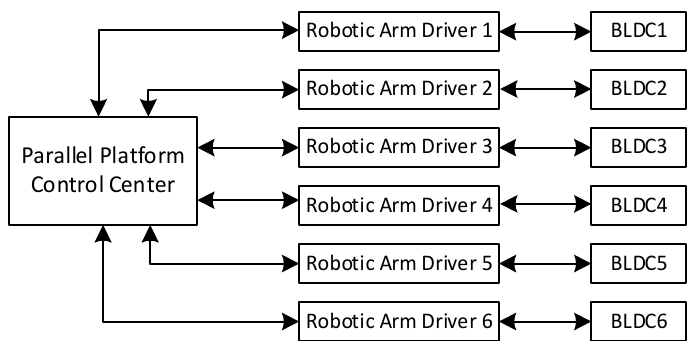
Figure 1. The overall structure of the parallel platform control system.